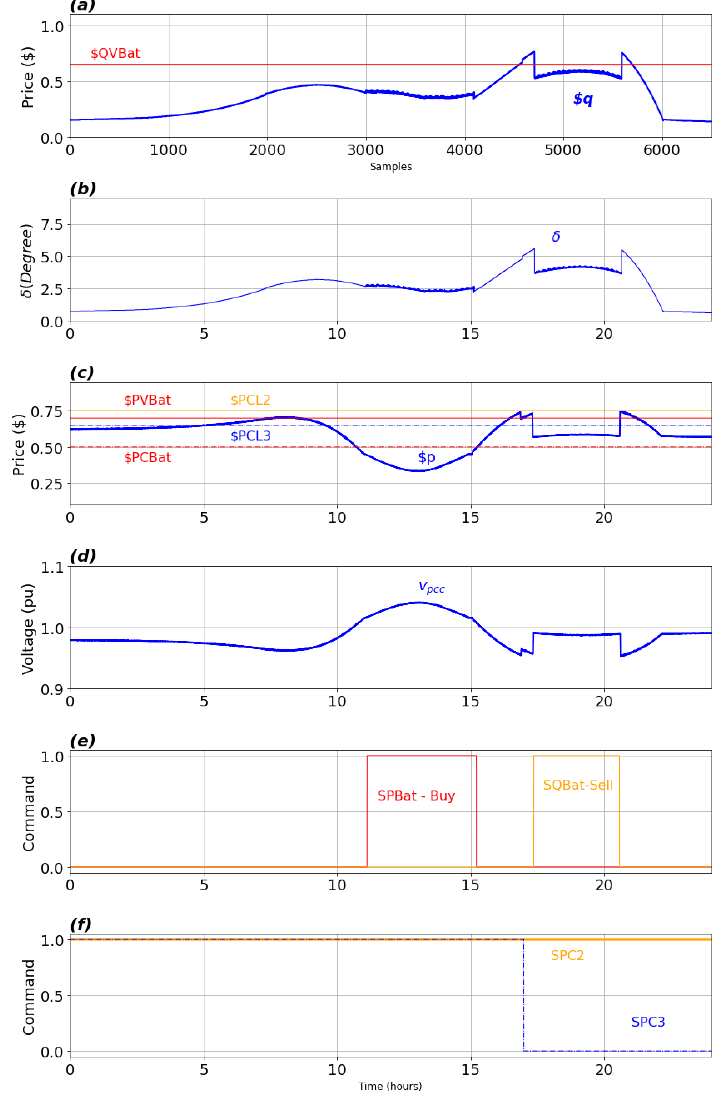
Figure 26. MG operating in connected mode with reactive power consumption. Commands: ( a ) Re- active energy price; ( b ) Bus angle; ( c ) Active energy price; ( d ) Bus voltage; ( e ) Battery bank command; ( f ) Load e and 3